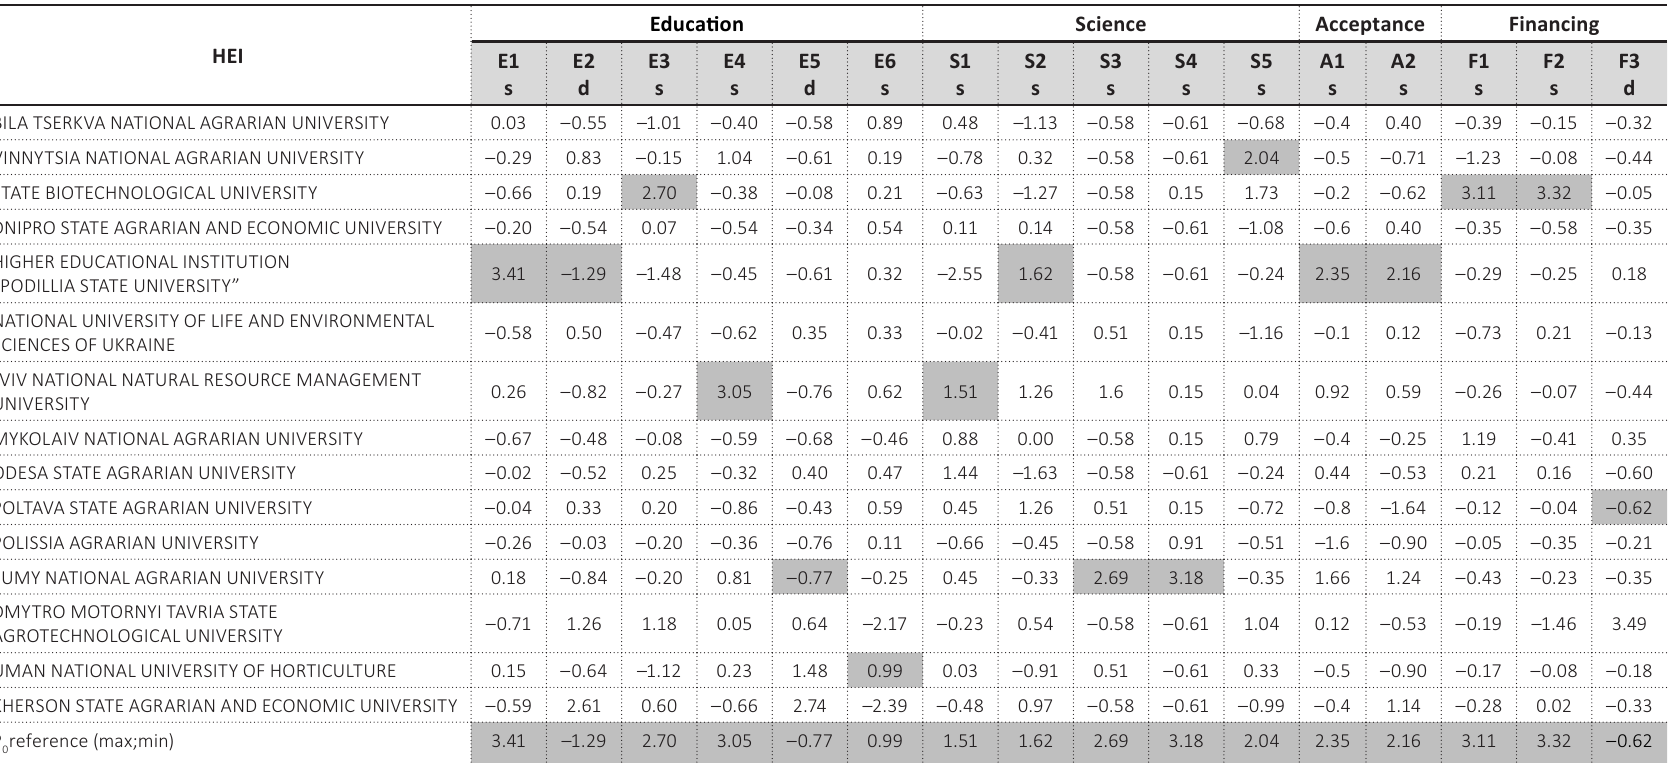
Table A1. Standardized input data matrix for evaluating the University Integral Sustainability